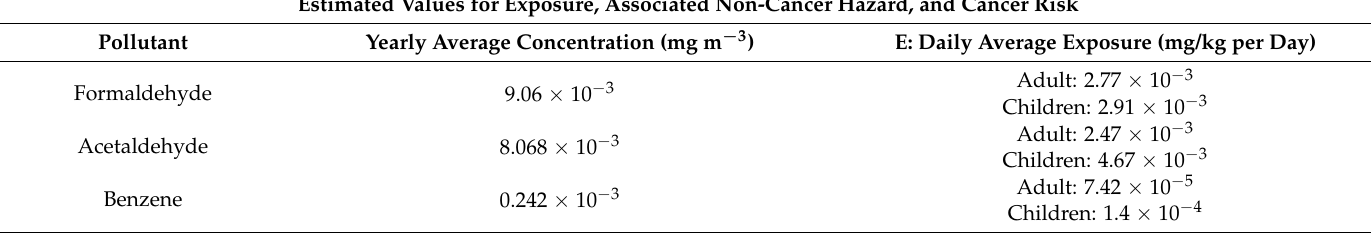
Table 9. Estimated values for exposure for formaldehyde, acetaldehyde and benzene found in this study.